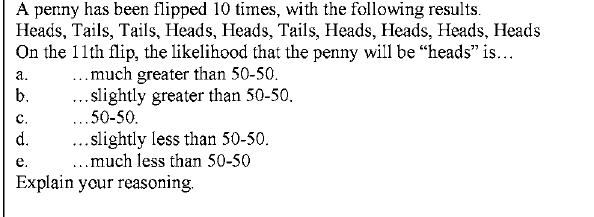
FIG. 5. Probability question. The question was designed to elicit the gambler’s fallacy and other issues related to expectation